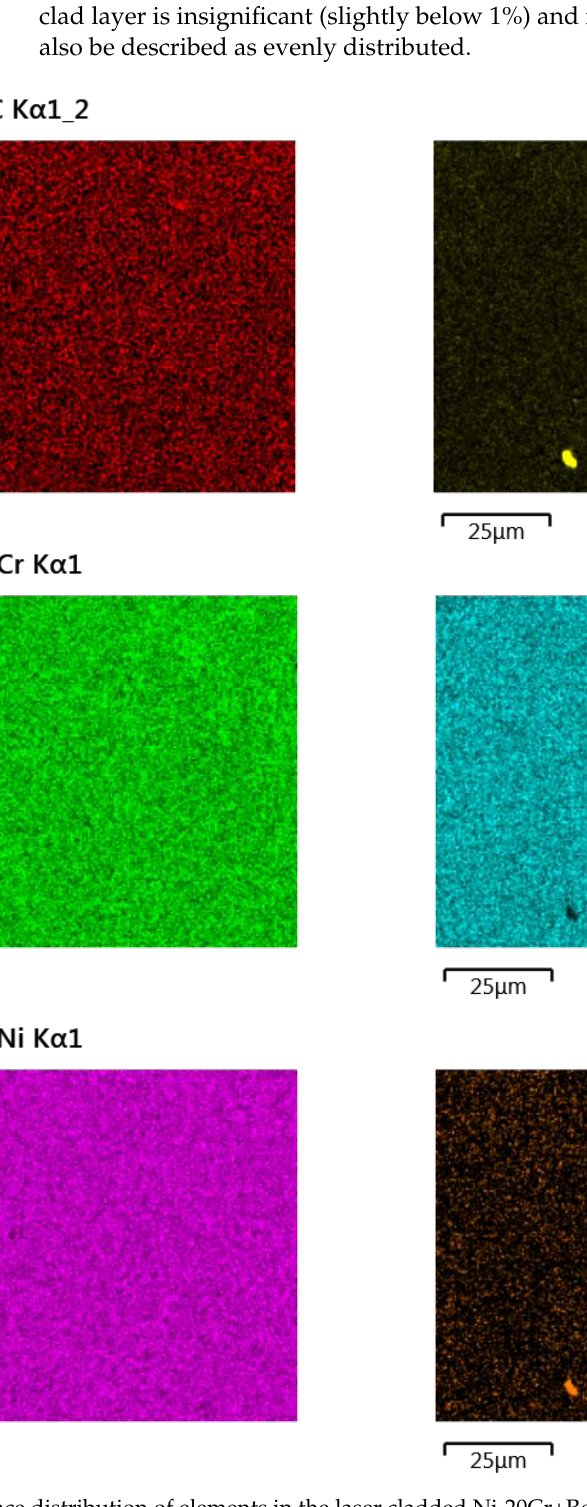
Figure 8. EDS spectrum obtained from the Ni-20Cr+Re clad produced at different laser power: ( a ) 1500 W, ( b ) 1800 W, ( c ) 2100 W, ( d ) 2400 W, ( e ) 2700 W, ( f ) clad area taken for the analysis.